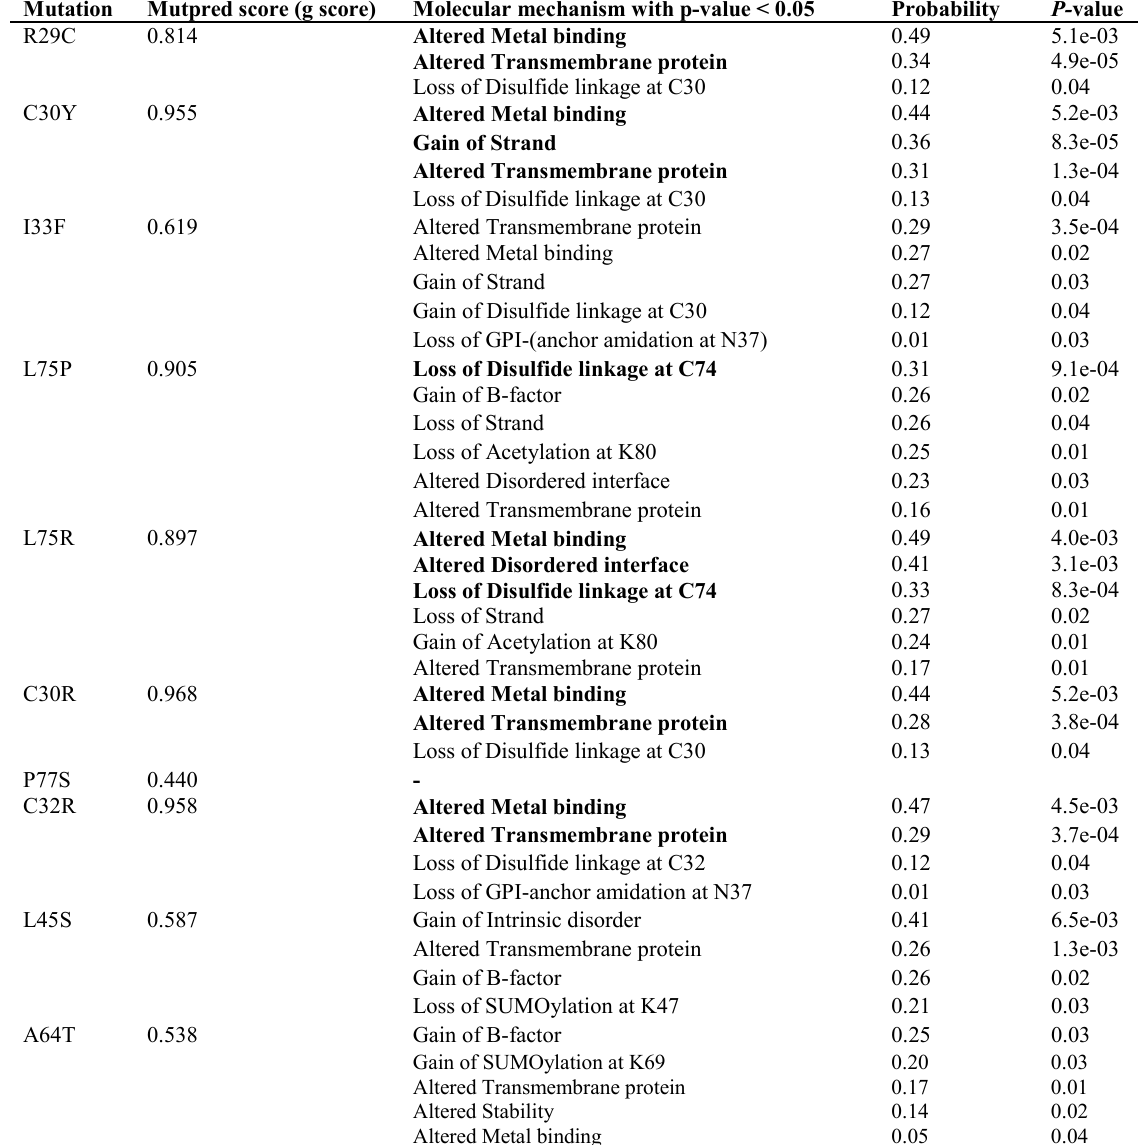
Fig. 2. The heat map provided by the SNAP2 for the most deleterious nsSNPs. The map represents all the possible substitutions in every position. The severity and influence of each substitution are shown by specific colors; dark red means strong effect, white shows weak signals, and blue indicates no effect. Wildtype residues in each position are marked by black. (the color must be used). Table 3 . The resultant probability scores for the most deleterious nsSNPs as provided by MutPred. All the changes showing a very high confident hypothesis are shown in